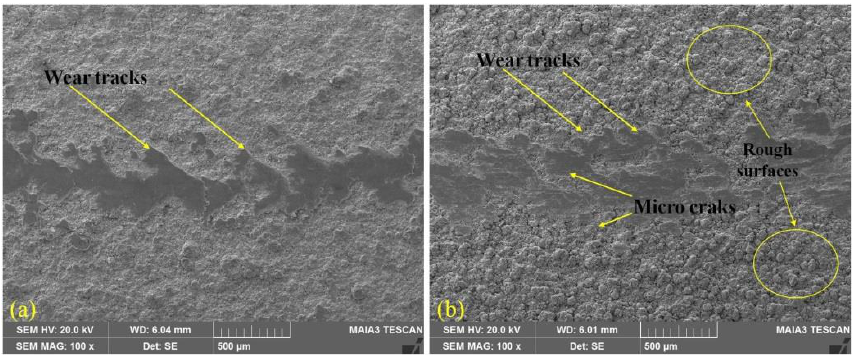
Figure 3. SEM micrographs after wear test at 250 °C under 2 N load: ( a ) D-gun coating technique; ( b ) SSPS coating technique.